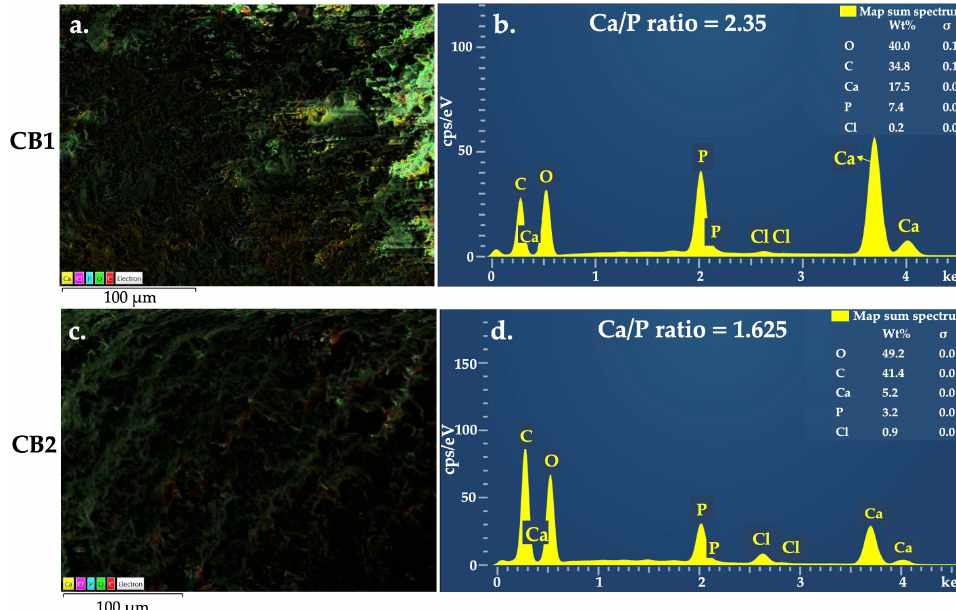
Figure 3. EDX mapping for ( a ) CB1 and ( c ) CB2 and Elemental analysis for ( b ) CB1 and ( d ) CB2